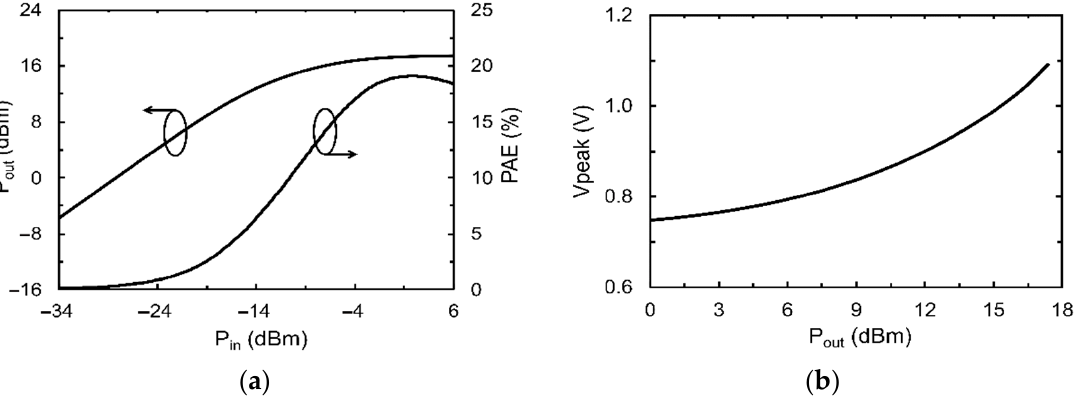
Figure 7. ( a ) Measured PA output power and PAE versus input power. ( b ) Measured peak detector voltage versus output power.